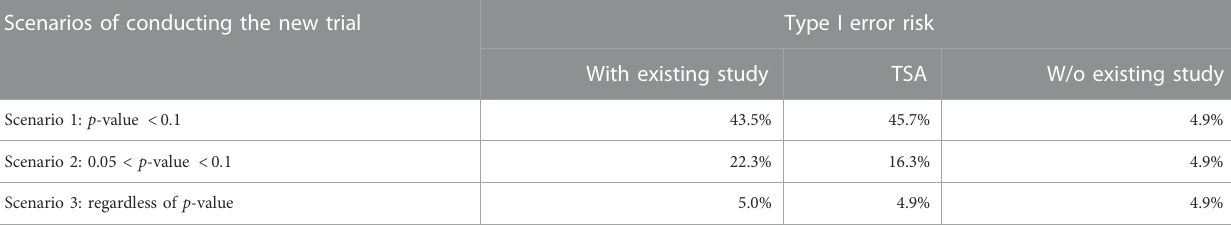
TABLE 3 Simulation Study 2: Type I error risk (100,000 simulation) under different scenarios of conducting new study with a fi xed sample size of 103 and three analysismethods(TSA,withexistingstudy,andw/oexistingstudy).Inthesimulation,theeffectsizeis0betweenGAMIandFLOR.The p -valueinthetablerefersto the p -value ( H 0 : the effect size is 0 between GAMI and FLOR) in the existing study. Scenarios of conducting the new